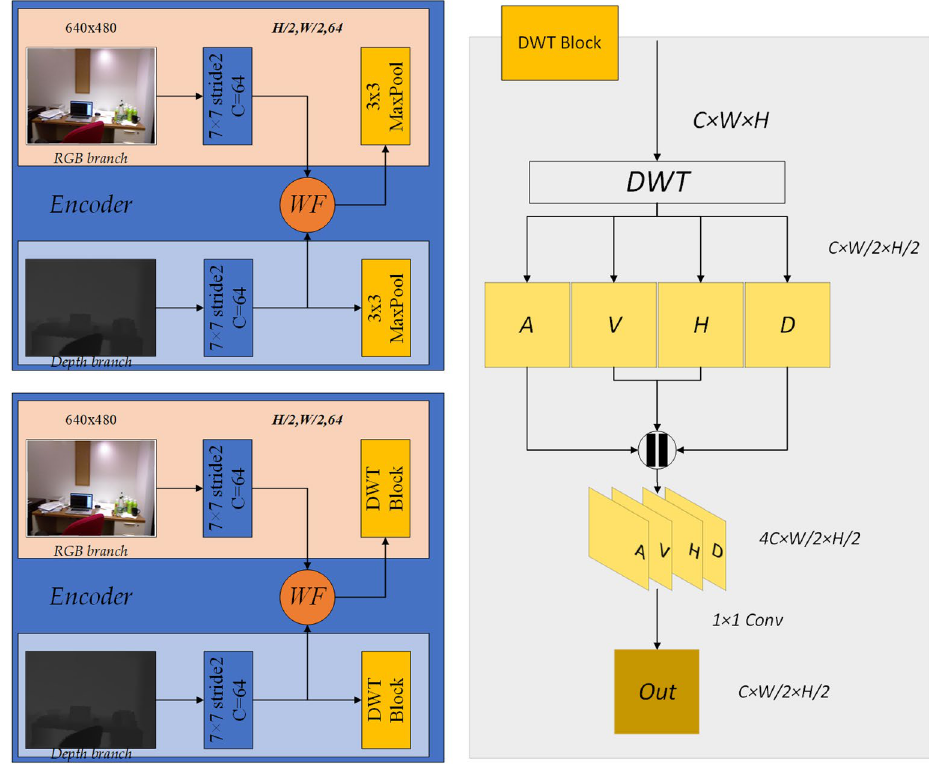
Figure 7. Compare with pooling operations.